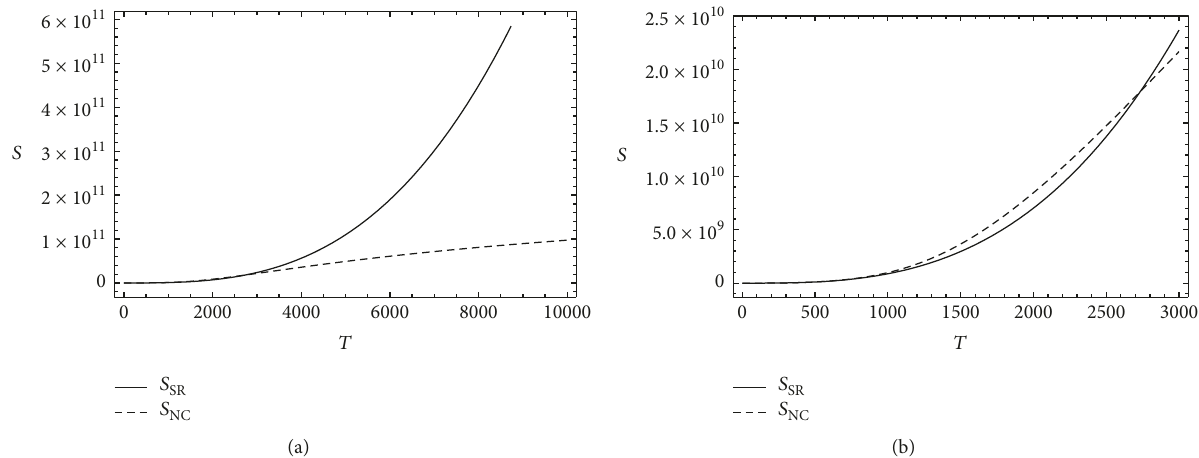
Figure 3: Entropy in SR and NC model. The units and the parameters are the same as in Figure 1. The NC model results have been obtained numerically using Mathematica